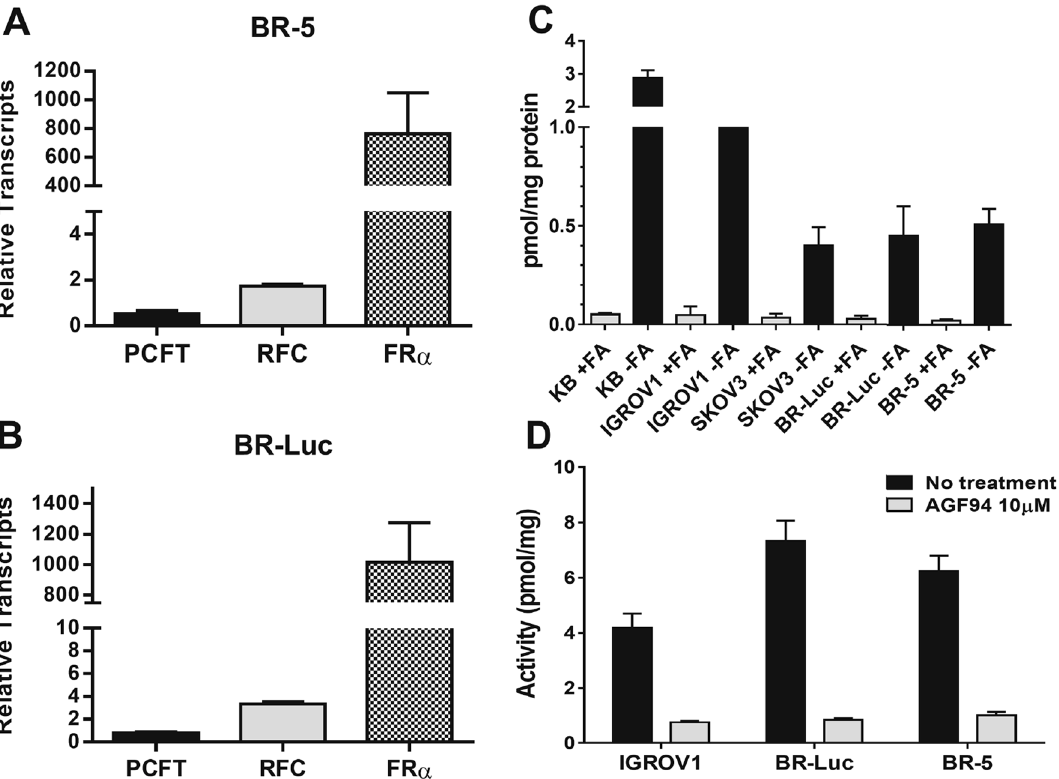
Figure 3. Folate transporter expression and function in BR-5 and BR-Luc syngeneic HGSOC mouse models. Transcript levels for PCFT, RFC and FRα were measured by real-time RT-PCR for BR-5 ( A ) and BR-Luc ( B ) cells. Transcripts were normalized to β-actin transcripts and levels are shown relative to those in mouse liver (assigned a value of 1). ( C ) Total surface FRα was measured by titration with [ 3 H]folic acid at 0 °C with and without unlabeled 10 µmol/L non-radioactive folic acid. ( D ) PCFT uptake was assayed using [ 3 H]MTX (0.5 µM) at pH 5.5 at 37 °C in the absence and presence of 10 µM non-radiolabeled AGF94 , as previously described 22 . Results are presented as mean values (± standard errors) from at least three experiments.